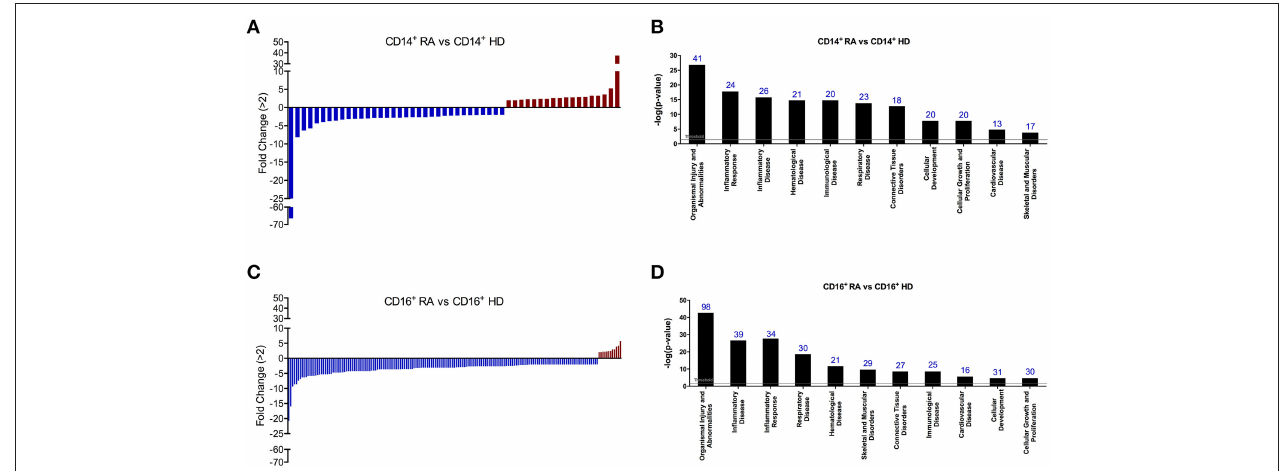
FIGURE 4 | CD14 + and CD16 + monocytes of RA patients display specific and distinctive microRNA expression profiles. (A) Thirty-one microRNAs were found significantly altered in CD14 + monocytes isolated from RA patients compared with CD14 + HD monocytes using a fold change cut-off of > 2. (B) Functional classification of the altered microRNAs in CD14 + RA monocytes using Ingenuity Pathway Analysis (IPA, QIAGEN Redwood City, https://analysis.ingenuity.com). The analysis included only the functions and pathways with average IPA score > 2 [indicated as –log ( p -value)].To minimize false positives among significantly enriched functions, a false discovery rate (FDR) < 0,05 (–log P -value = 1,33) was used to determine the probability that each biological function assigned to that data set was due to chance alone’. Threshold bar indicates cut-off point of significance ( p > 0.05), using Fisher’s exact test, microRNAs. (C) One hundred and seventy-three microRNAs were found significantly altered in CD16 + monocytes isolated from RA patients compared with CD16 + HD monocytes using a fold change cut-off of > 2. (D) Functional classification of the altered microRNAs in CD16 + RA monocytes using Ingenuity Pathway Analysis. The analysis included only the functions and pathways with average IPA score > 2 [indicated as –log ( p -value)]. Threshold bar indicates cut-off point of significance ( p > 0.05), using Fisher’s exact test,